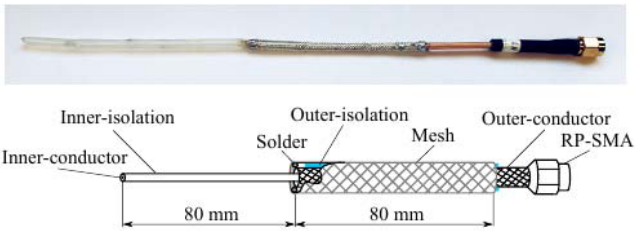
Figure 7. Photo (top) and schematic (bottom) of an underwater sleeve-dipole antenna for EM localization.